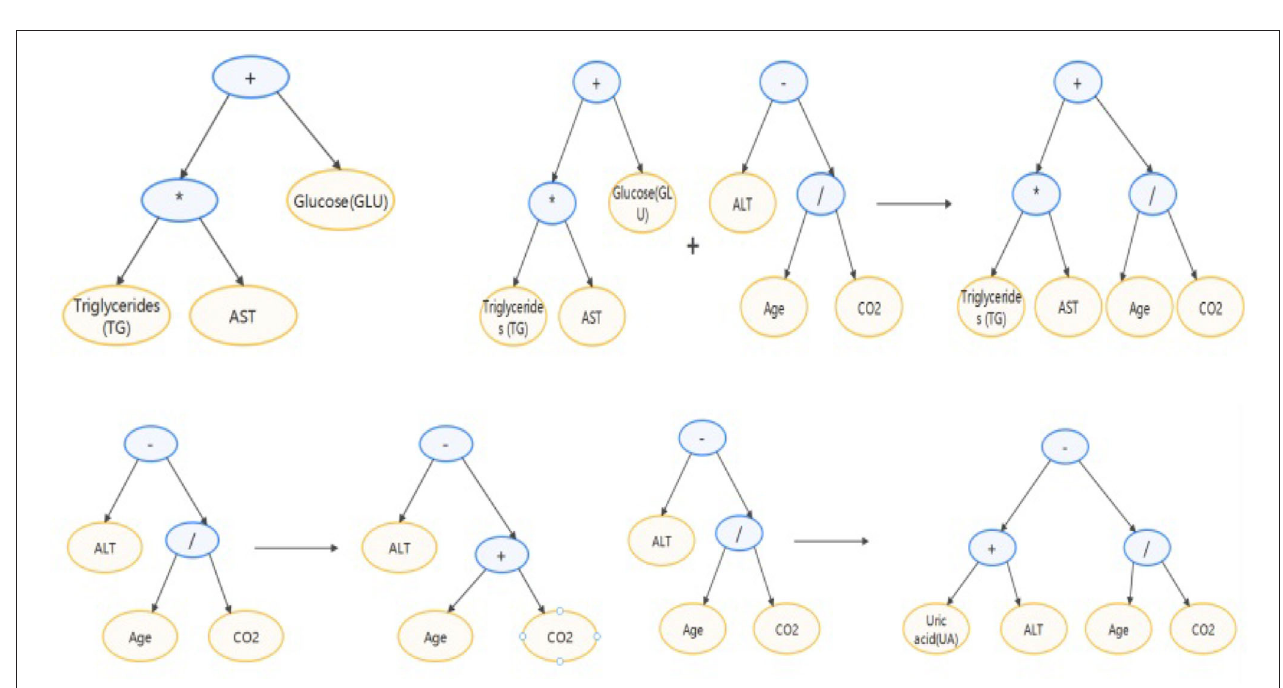
FIGURE 5 | Demonstration of individual and individual variation.